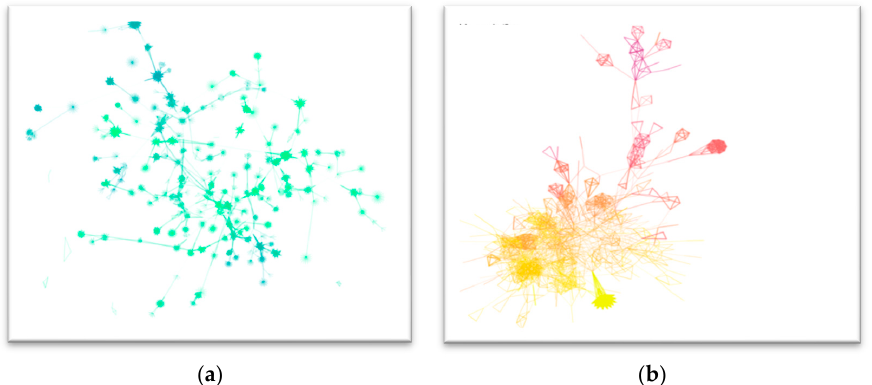
Figure 2. Visualized comparative analysis: ( a ) Network for electronic commerce field of research; ( b ) Network for cybersecurity field of research, designed by authors. Note: The more obvious the color, the more recent the publications.